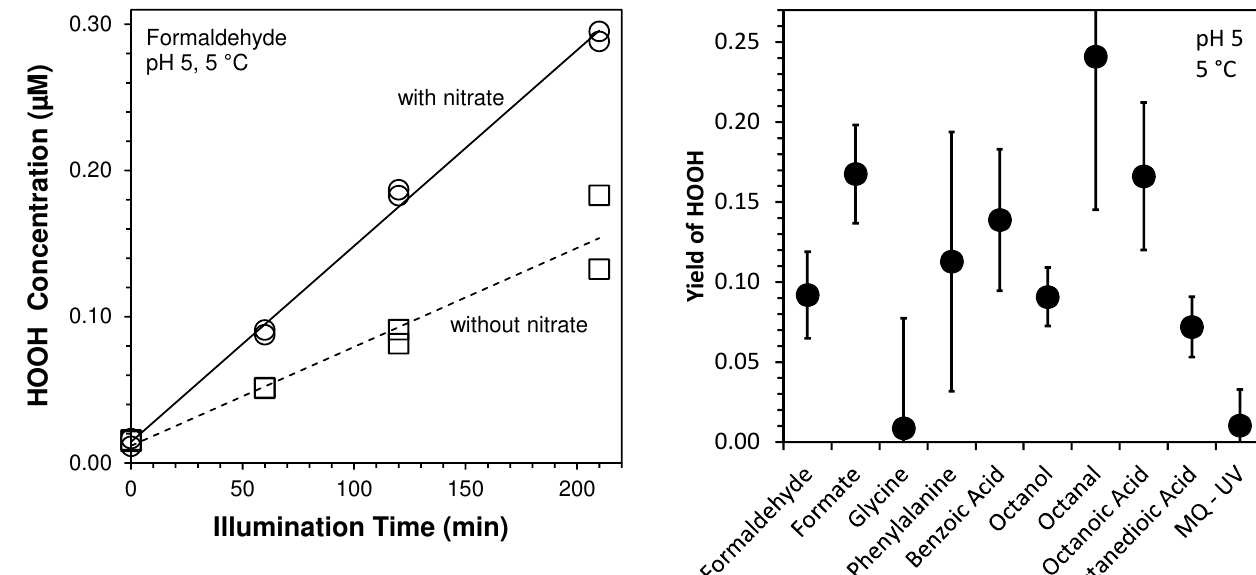
Fig. 3. Yield of hydrogen peroxide from the reaction of each model organic compound (pH 5, 5 ◦ C). Error bars ( ± 1SE) are the absolute error (net indeterminate error), calculated based on the propagated errors from R (HOOH), j (2NB), and R (OH).